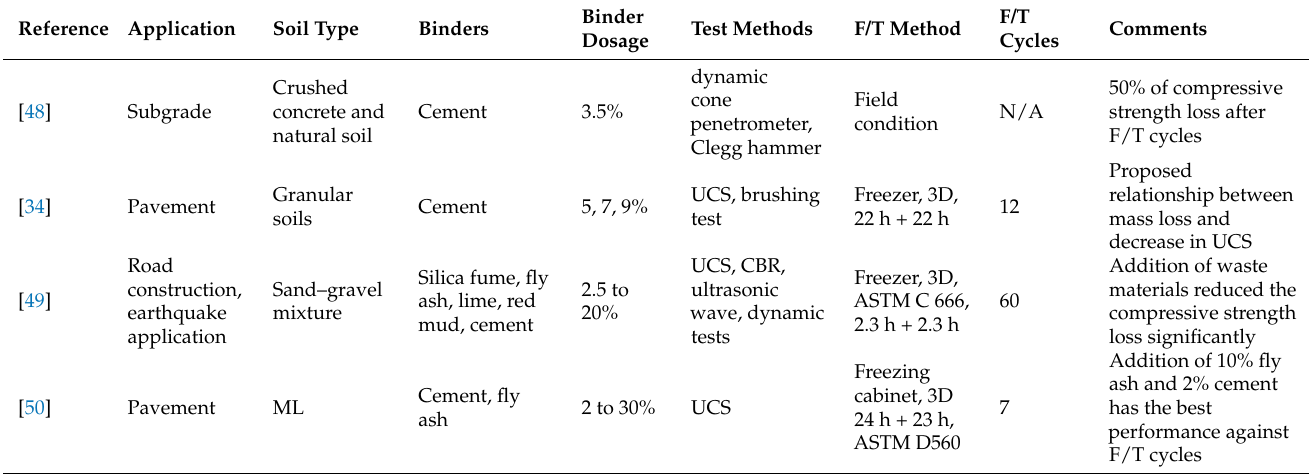
Table 2. Key references on the performance of soilcrete subject to F/T